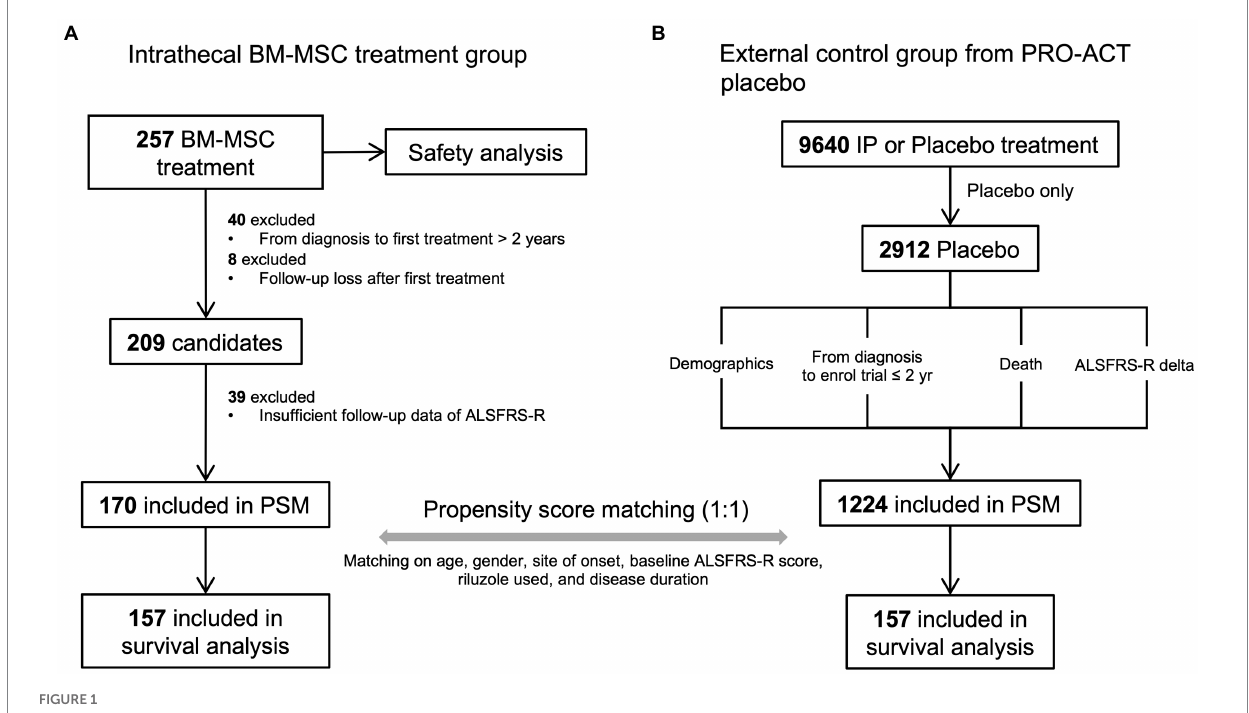
FIGURE 1 The propensity-score-matched participant selection for survival and safety analysis and data pre-processing steps. (A) BM-MSC treatment cohort. A total of 257 participants were administered lenzumestrocel. Safety evaluation was conducted during a one-year follow-up period after the first treatment. Survival analysis was performed on propensity score matched 157 participants. (B) external control group from the PROACT database. Only 2,912 placebo participants were extracted out of 9,640 participants in the treatment group data (treatement.csv). Participants who enrolled in the